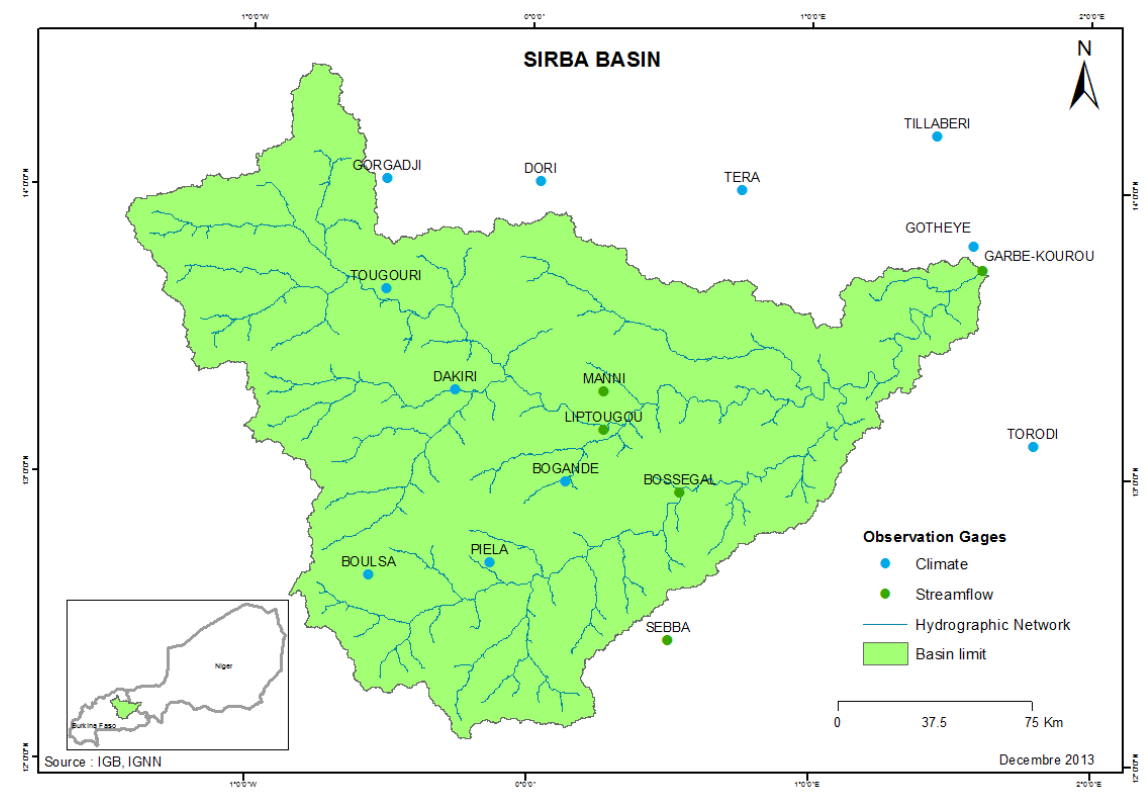
Figure 1. Sirba watershed and observation